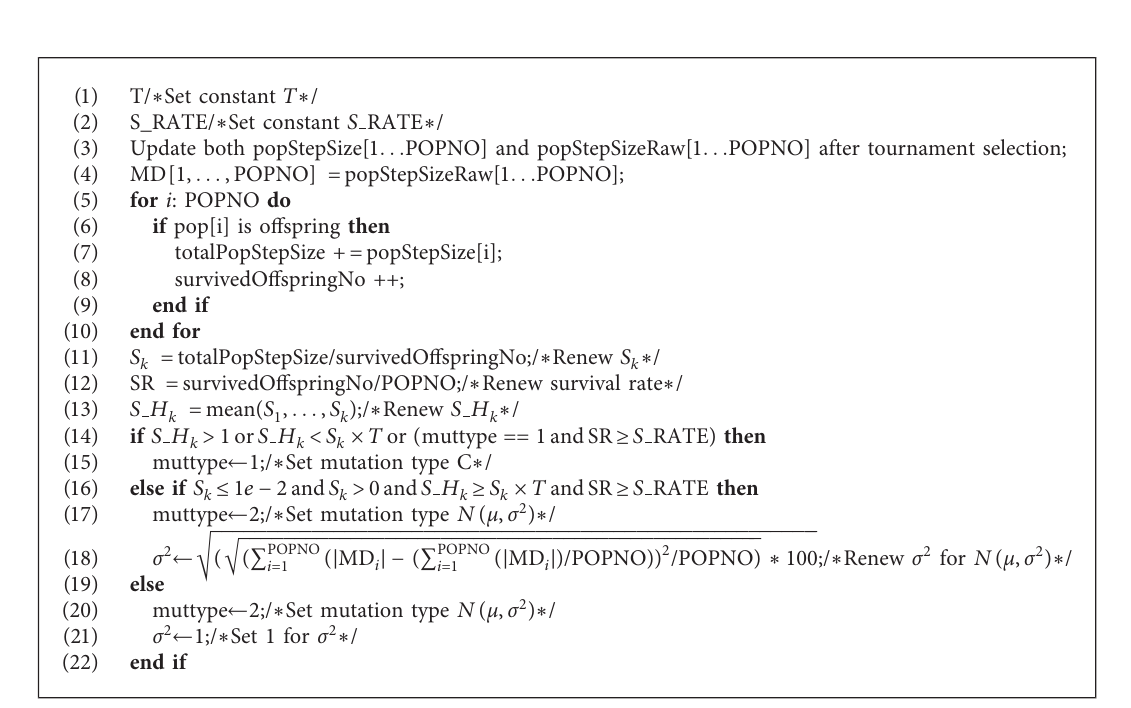
Table 3: Values of distance coefficient T for f